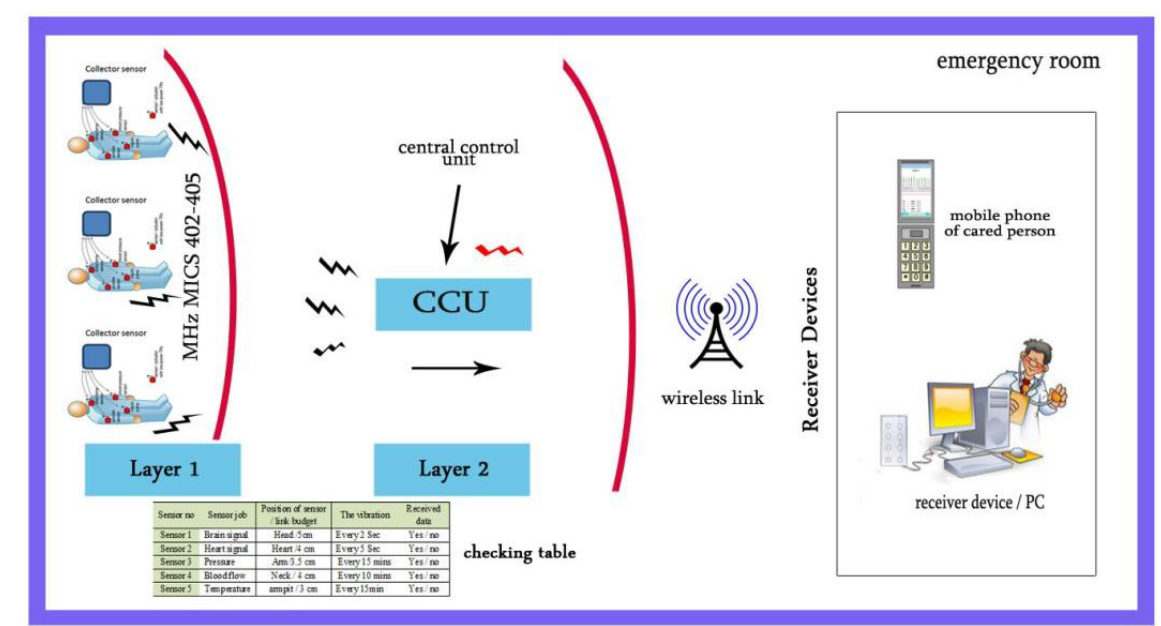
Figure 4: WBAN system that detects and transmits signals from a human